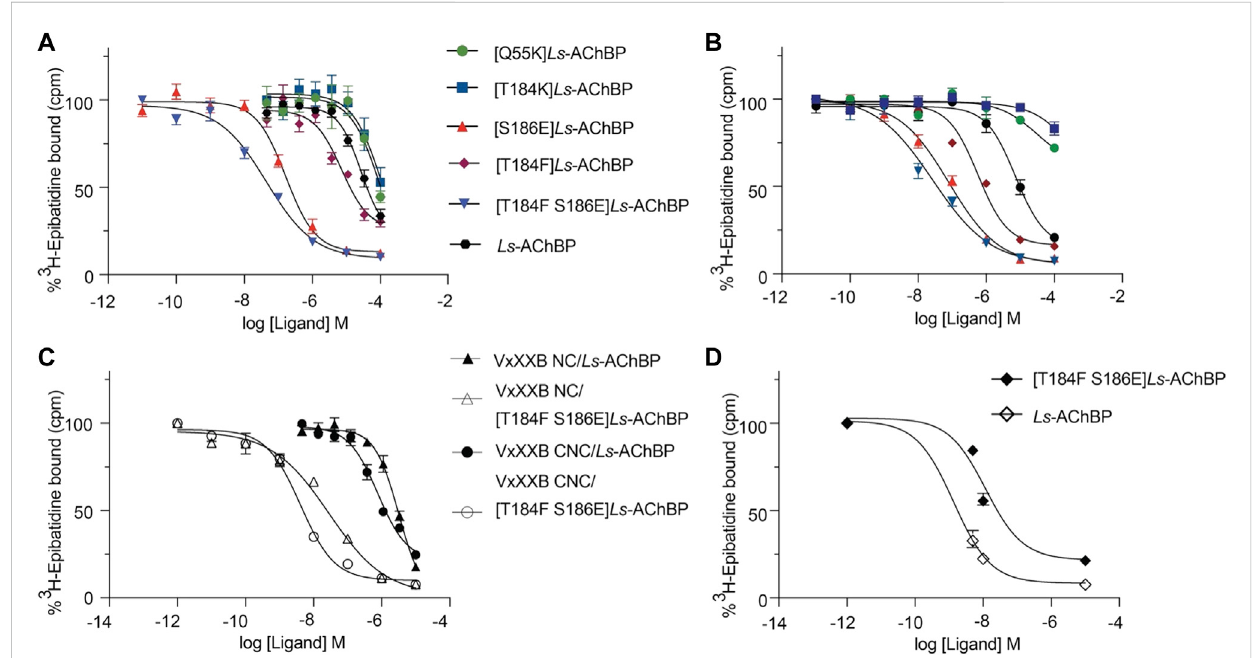
FIGURE 6 The displacement of [ 3 H]-epibatidine from wild-type and mutant Ls -AChBP by VxXXB-C (19 – 50) (A) , CTD (21 – 50) (B) , VxXXB-NC (C) , VxXXB-CNC (C) andnativeVxXXB (D) obtained via acompetitionradioligand bindingassay (duetolimitedsample,topofcurvewas fi xedto100%,andslope andcurve bottom fi xed to the bottom of VxXXB CNC ). Data represent means ± SEM of triplicate data from three independent experiments.